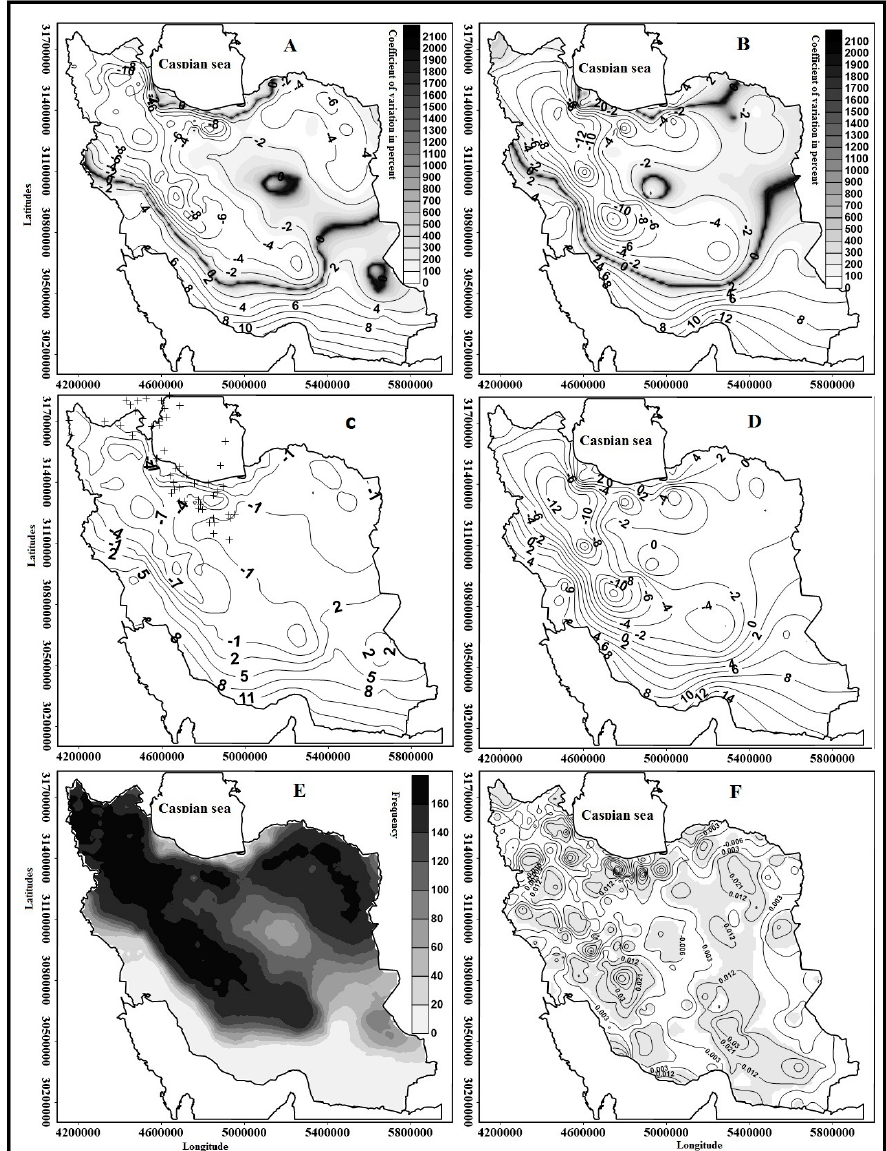
Figure 8. The third pattern: ( A ) Spatial distribution of temperature average and coefficient of variation for the whole group; ( B ) spatial distribution of temperature average and coefficient of variation for the representative day; ( C ) anomalies and center of masses for the whole group; ( D ) anomalies for the representative day; ( E ) frequency of frosts for the whole group; and ( F ) spatial distribution of the trend of Iran’s frosts for the whole group.